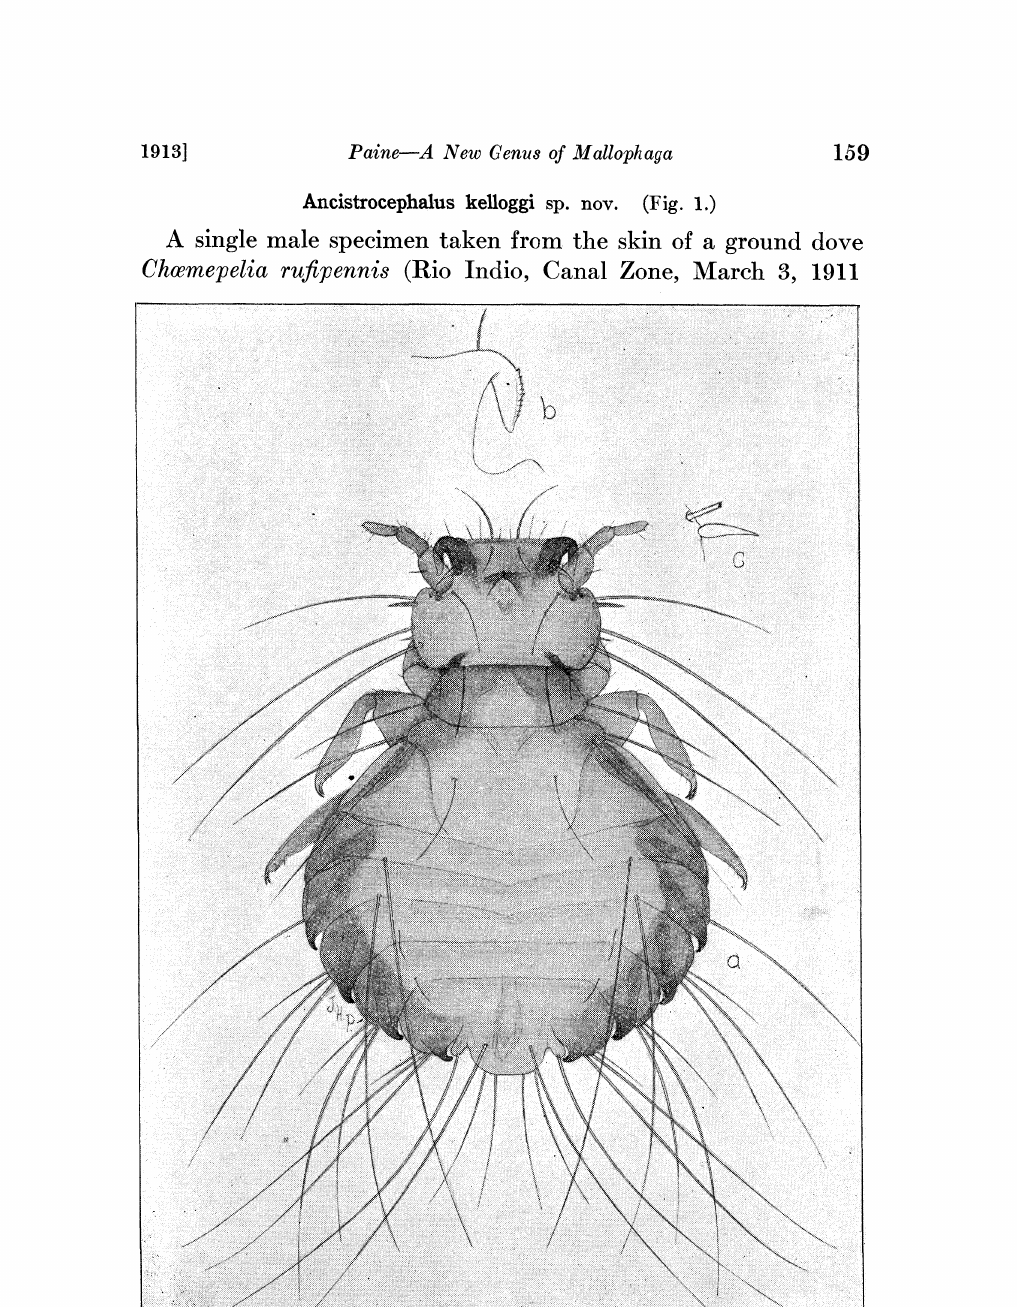
Fig. 1. Ancistrocephalus lcelloggi sp. nov., mule. a, dorsal view; b, anterior lateral angle of head; c, lateral spine